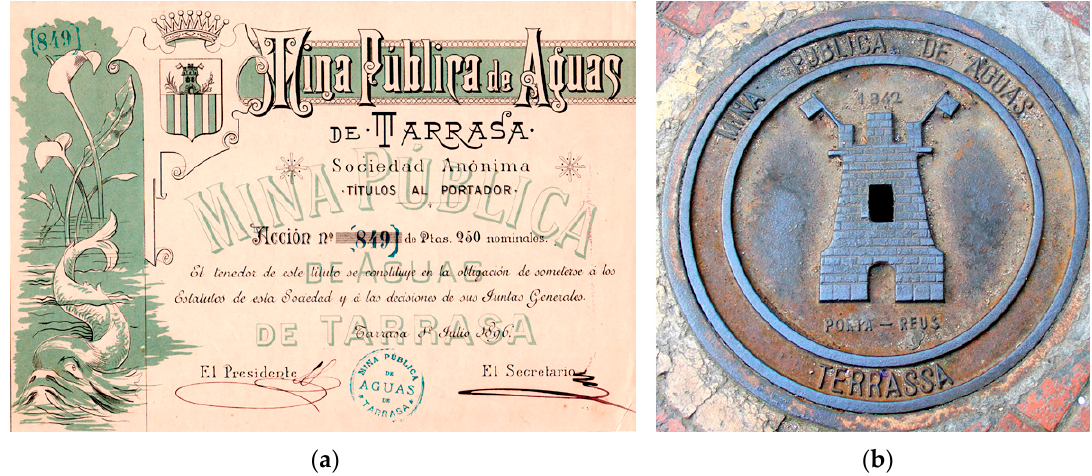
Figure 2. ( a ) Share of Mina P ú blica de Aguas de Tarrasa (1896); ( b ) company manhole cover.